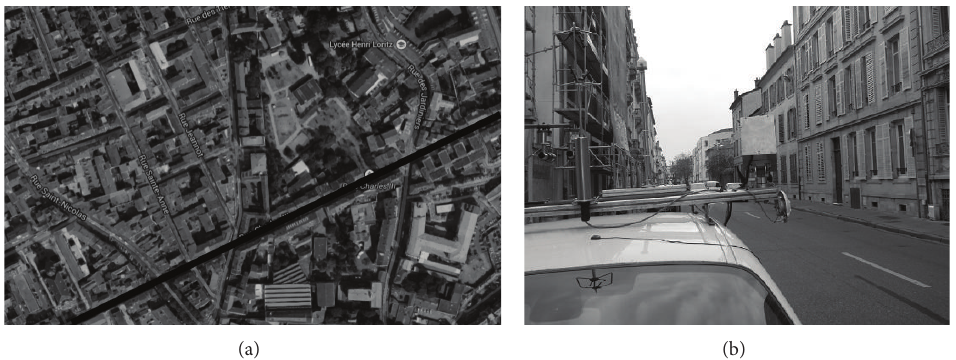
Figure 1: Thermal mapping route (black line) (a) and illustration of its urban configuration